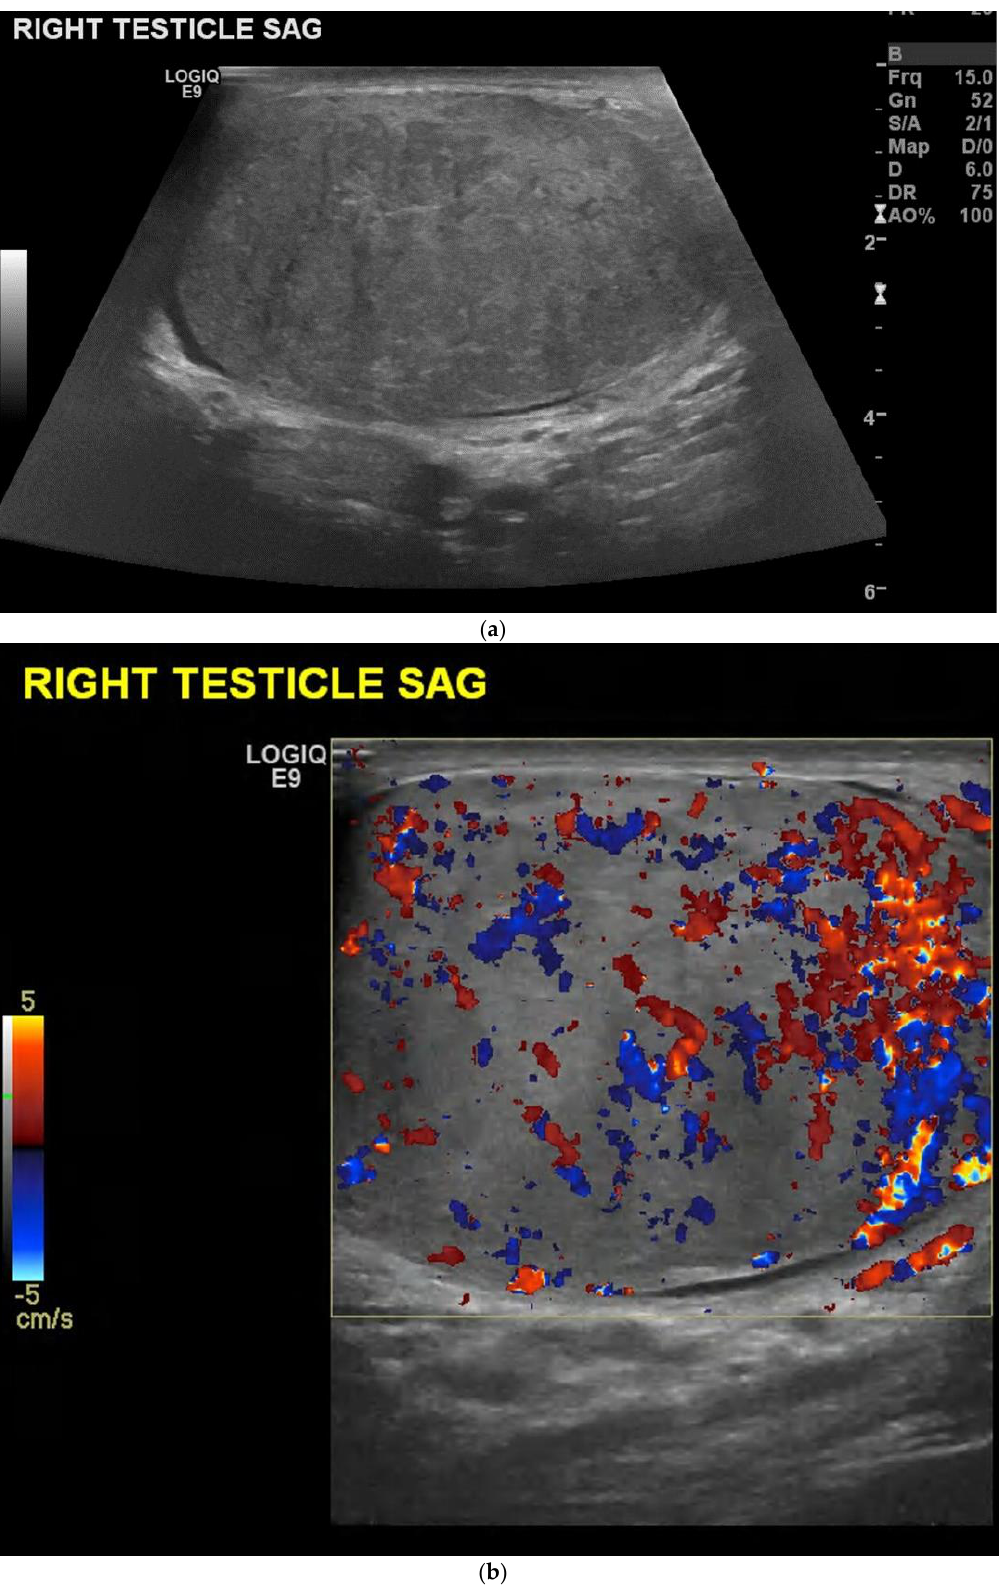
Figure 4. ( a ) B-mode ultrasound showing enlargement and infiltration of the testis by a large tumour, confirmed to be a mixed germ cell tumour. ( b ) Colour Doppler image shows marked vascularity throughout the